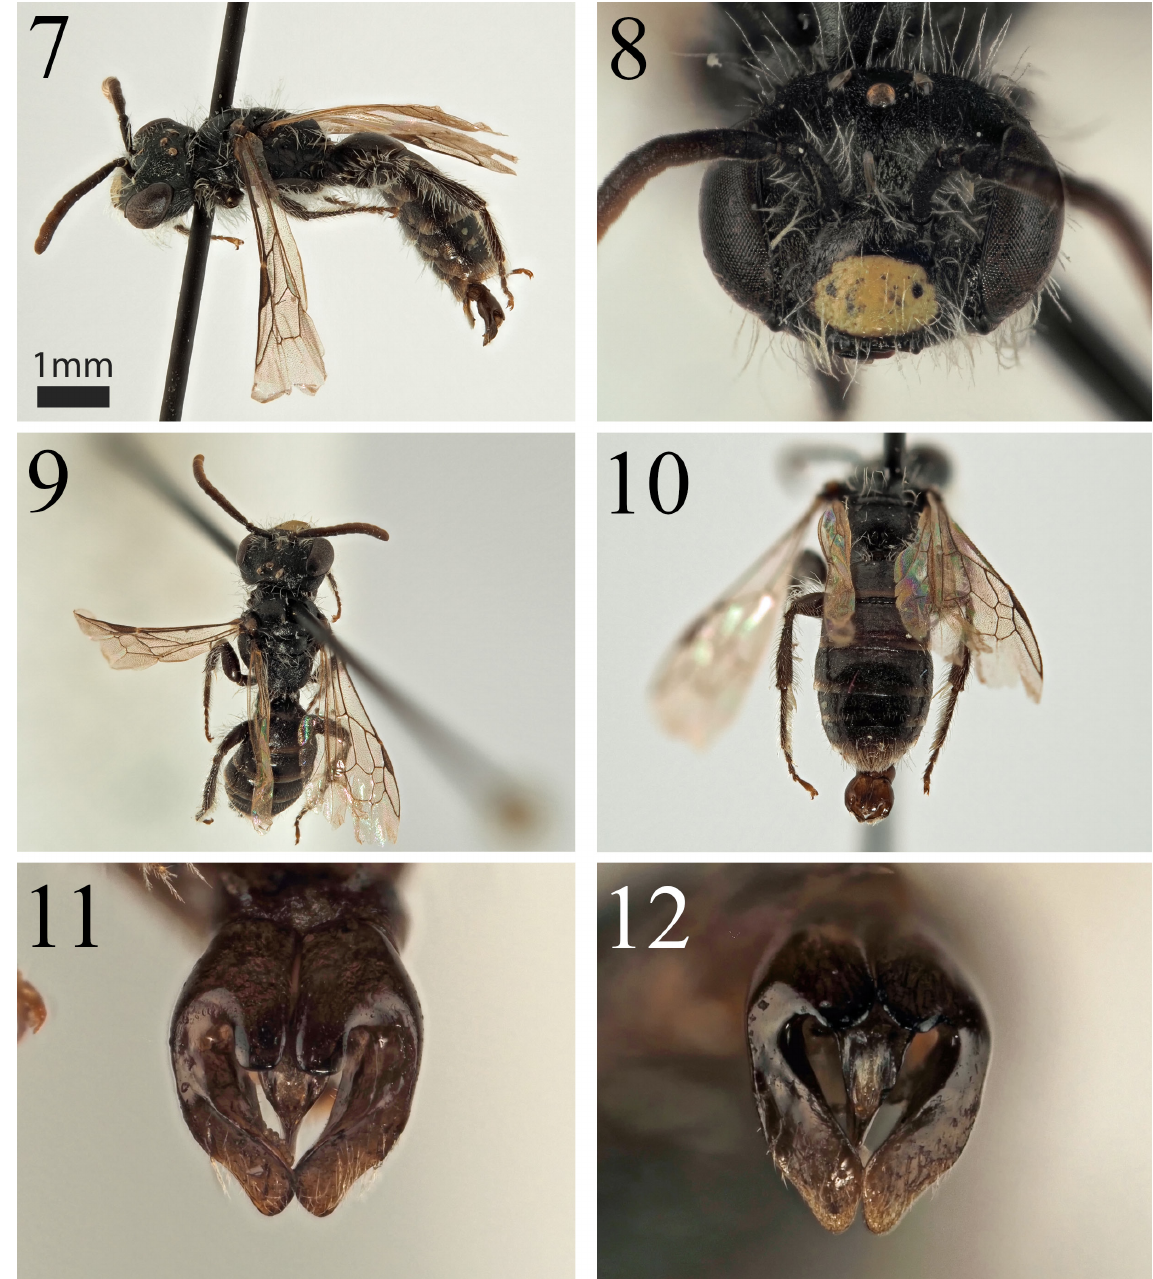
Figs 7–12. 7–11 . Andrena deminuta Wood sp. nov., ♂ (OÖLM). 7 . Profile. 8 . Face. 9 . Dorsum. 10 . Terga. 11 . Holotype genitalia (Lorestan Province). – 12 . Aff Andrena deminuta , ♂, genitalia (Fars Province)